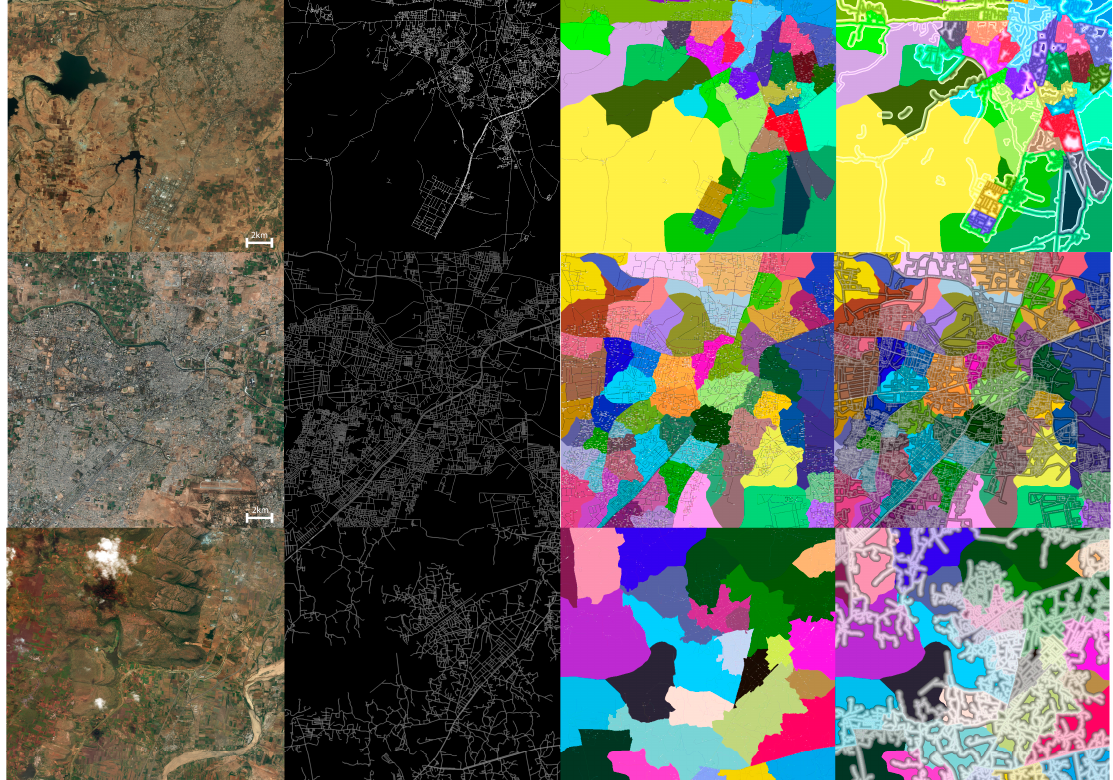
Figure 12. Street Addresses in Developing Countries. Satellite image, extracted roads, labeled regions and roads, and meter markers and blocks of three example unmapped cities. Table 1. The approximate number of inhabitants and population density are presented. We note that the population is per tile and the density is per city within the